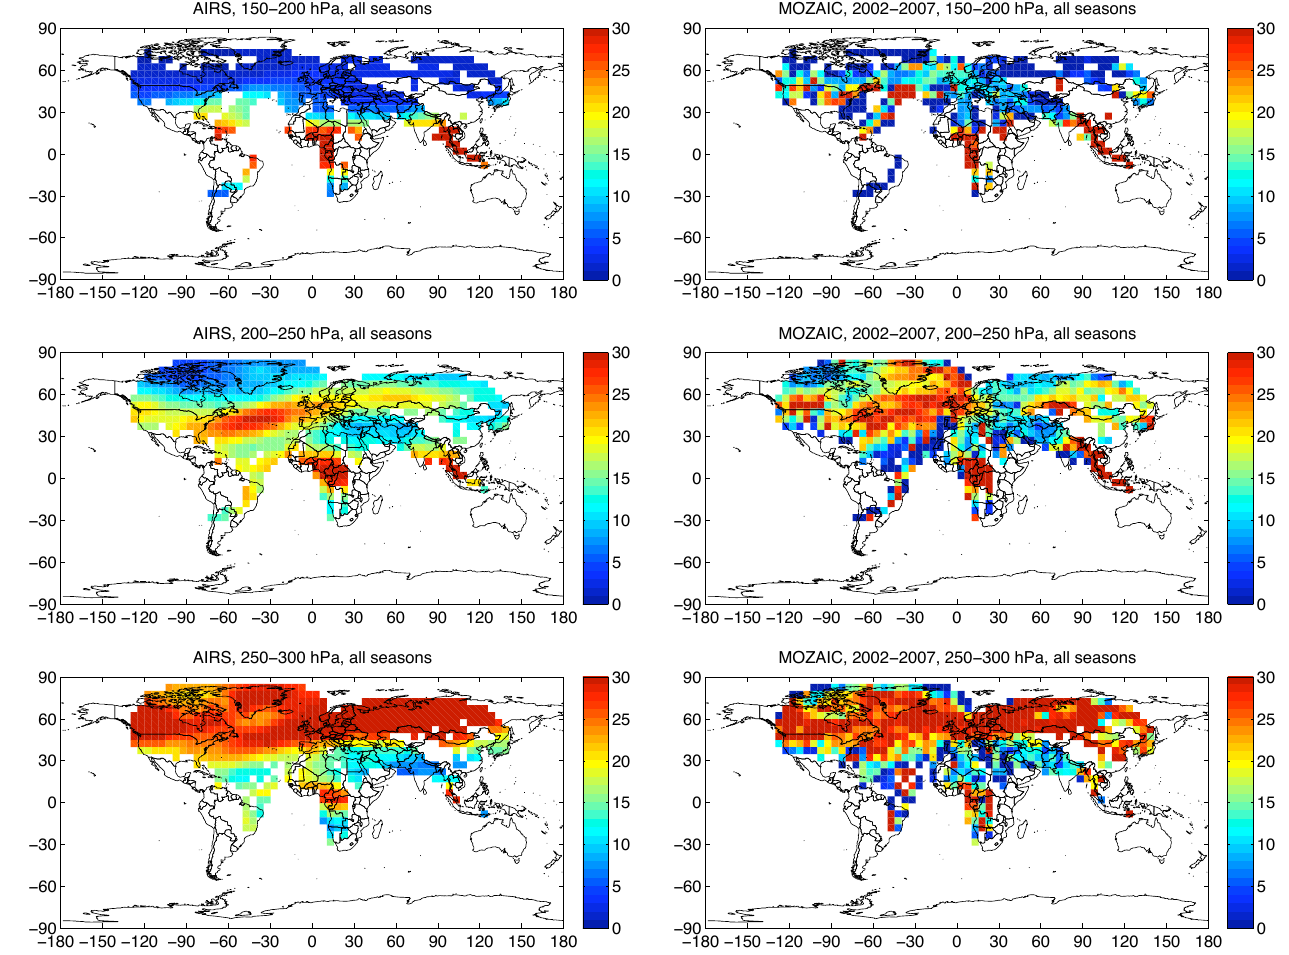
Fig. 12. Ice supersaturation occurrence frequencies (%) from AIRS (left) and MOZAIC (right) in the pressure layers 150–200, 200–250 and